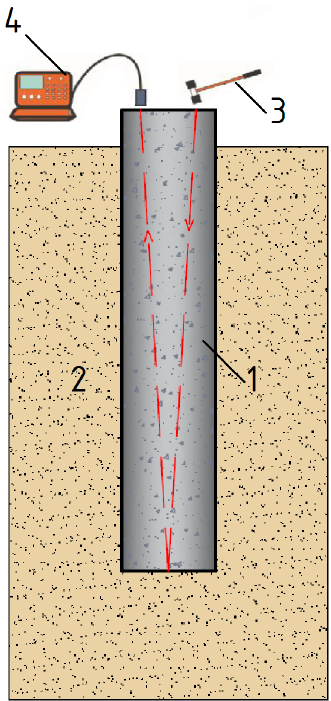
Figure 1. Testing piles: ( a ) flawless pile; ( b ) defect Ø250 mm, thickness 100 mm; ( c ) 100 × 150 × 300 mm; ( d ) 100 × 150 × 150 mm.